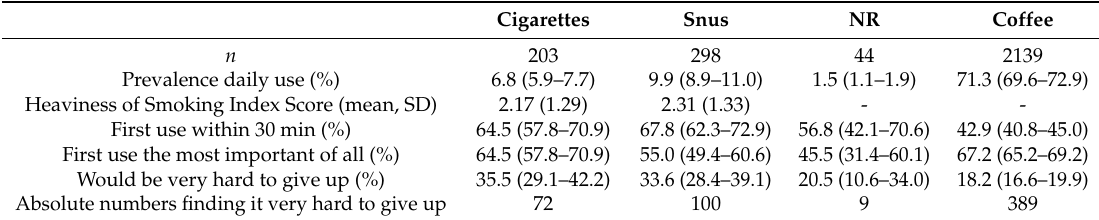
Table 2. Prevalence and indicators of dependence. Values in parentheses 95% confidence intervals unless otherwise stated.